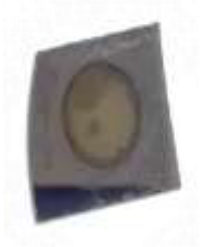
Figure 2 : Porous silicon sample.